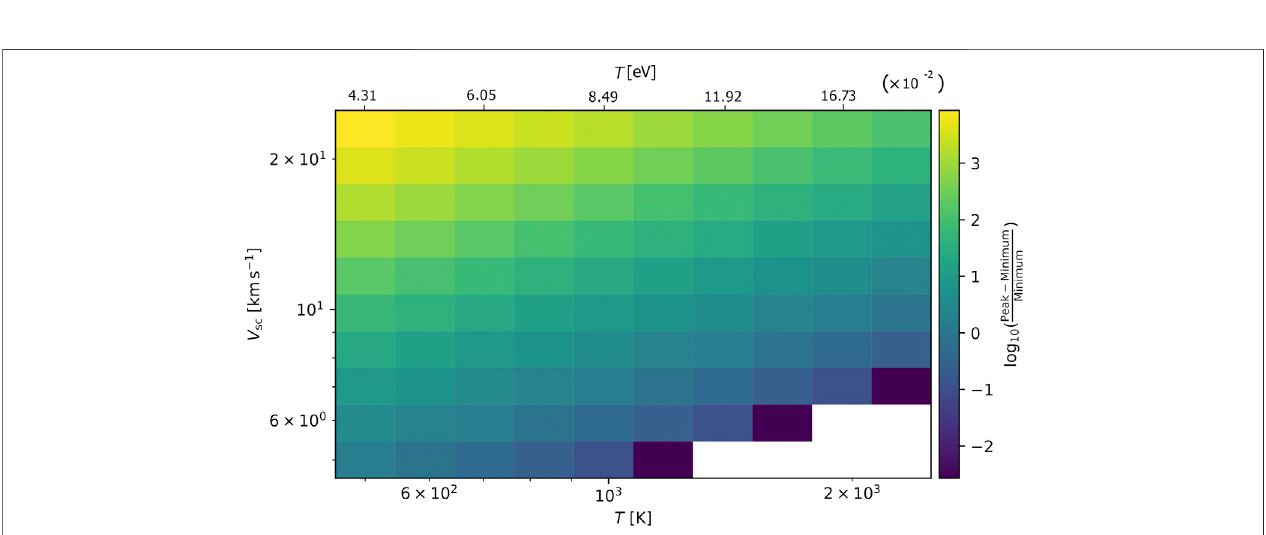
FIGURE 5 | Map of the achieved mass resolution index we use in this study (see Section 2.3 ), as a function of the ion temperature and the spacecraft speed, assuming static plasma, consisting of OH − and H 2 O-OH − . The mass resolution increases with increasing spacecraft speed and decreasing plasma